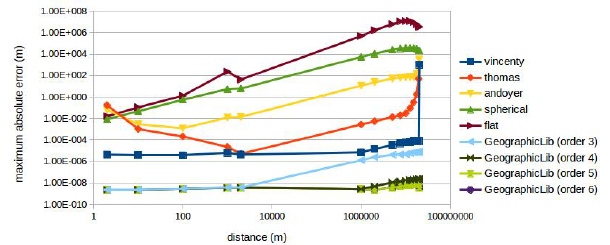
Figure 1. The maximum absolute distance error as a function of distance.